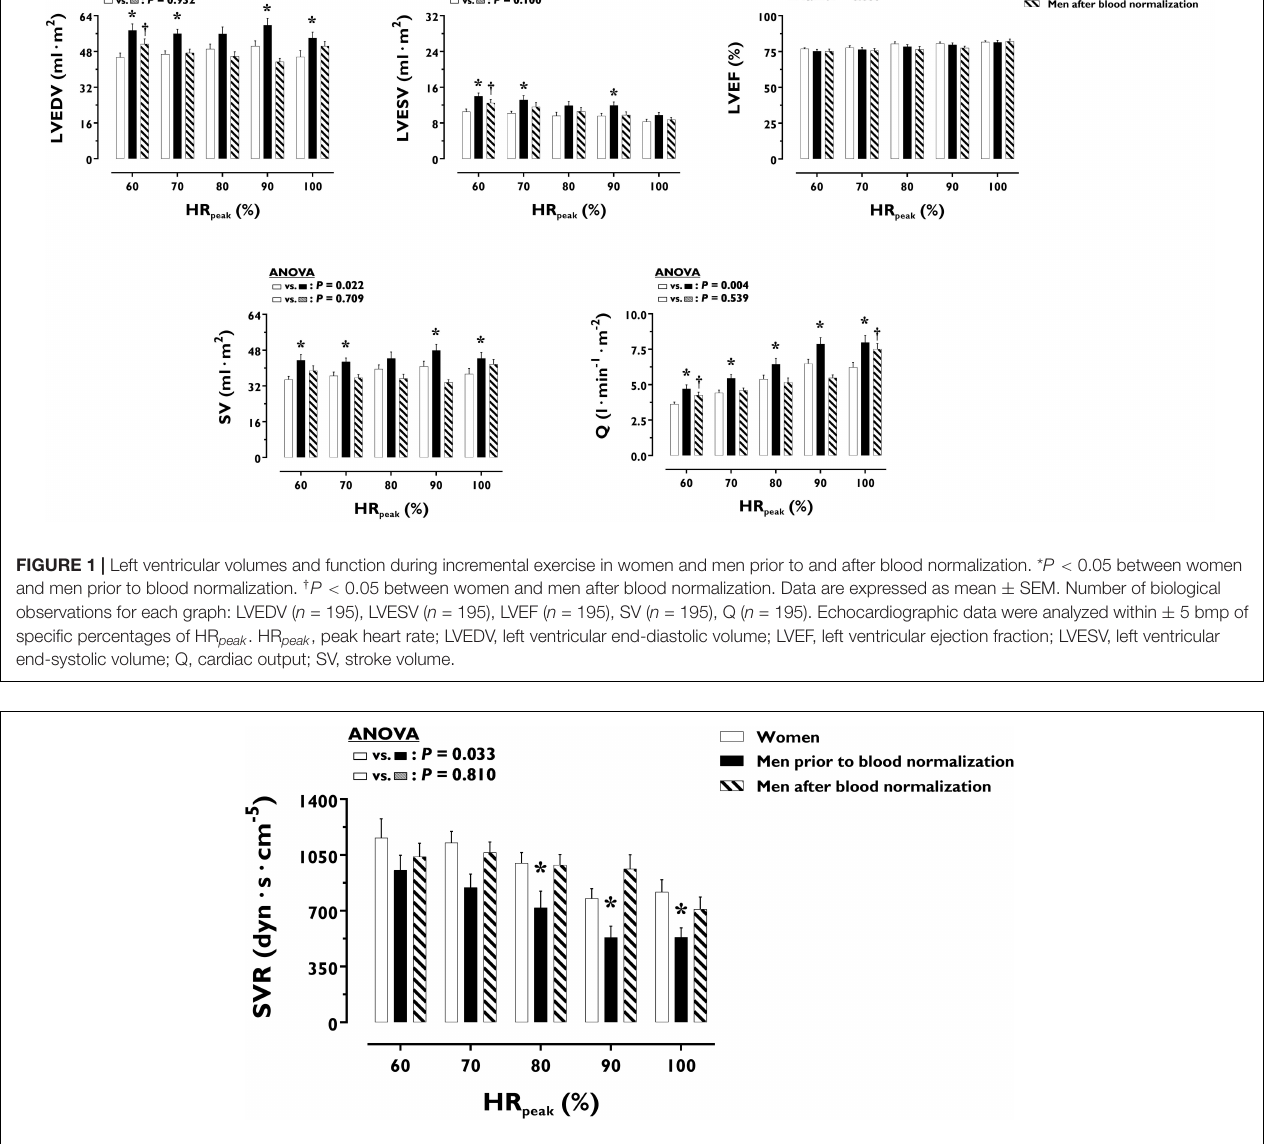
vs. 179.9 ± 9.4 bpm, P = 0.024) and was not altered after blood